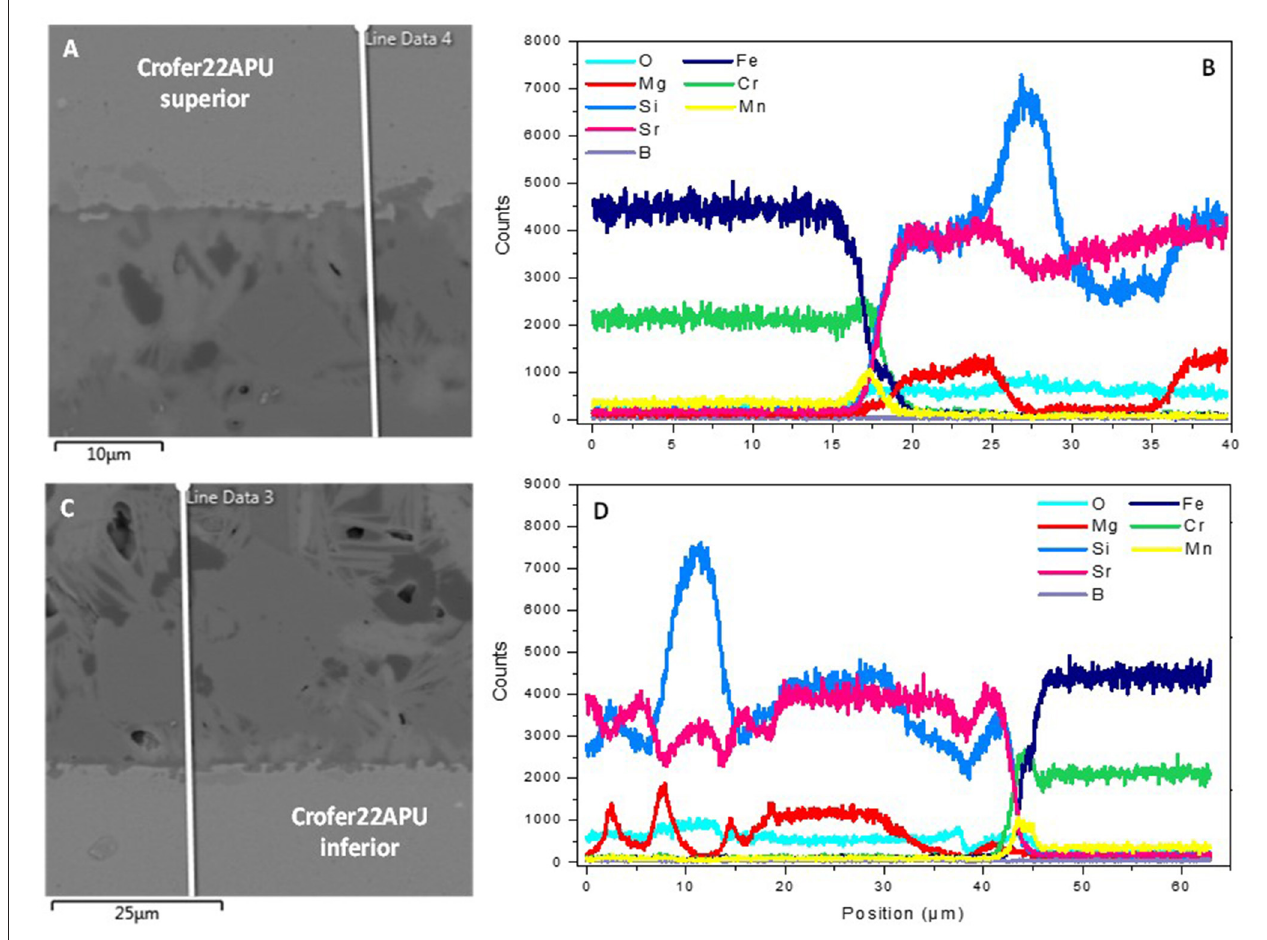
FIGURE 6 | (A) Magnification of the interface superior steel Crofer22APU/glass-ceramic and (B) EDX linear analysis. (C) Magnification of the interface inferior steel/glass-ceramic and (D) EDX linear analysis. Glass-ceramic of composition 10B(Sr) treated at 800 ◦ C for 800